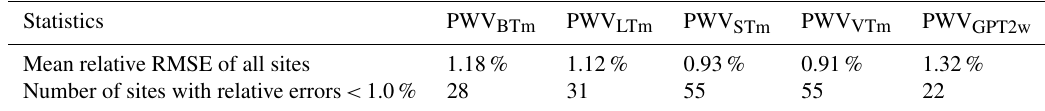
Table 5. Statistics on the relative errors of different PWV retrievals. Statistics PWV BTm PWV LTm PWV STm PWV VTm PWV GPT2w Mean relative RMSE of all sites 1.18% 1.12% 0.93% 0.91% 1.32% Number of sites with relative errors < 1.0% 28